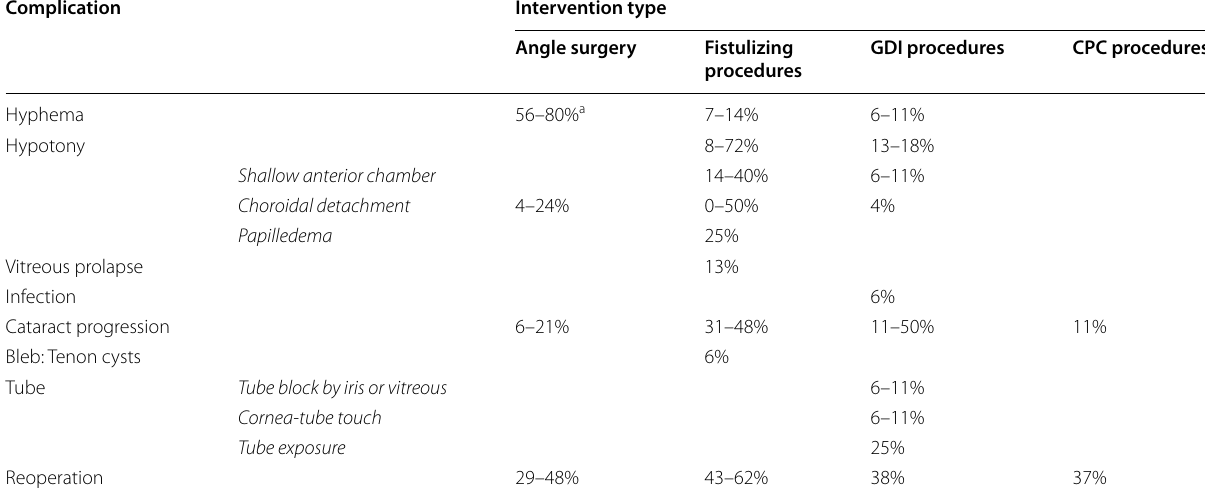
Table 2 Post-operative